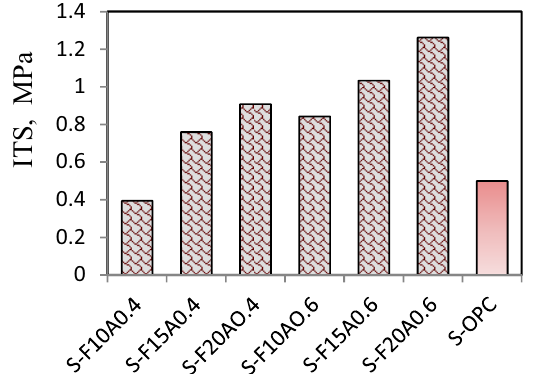
Figure 6: Indirect tensile